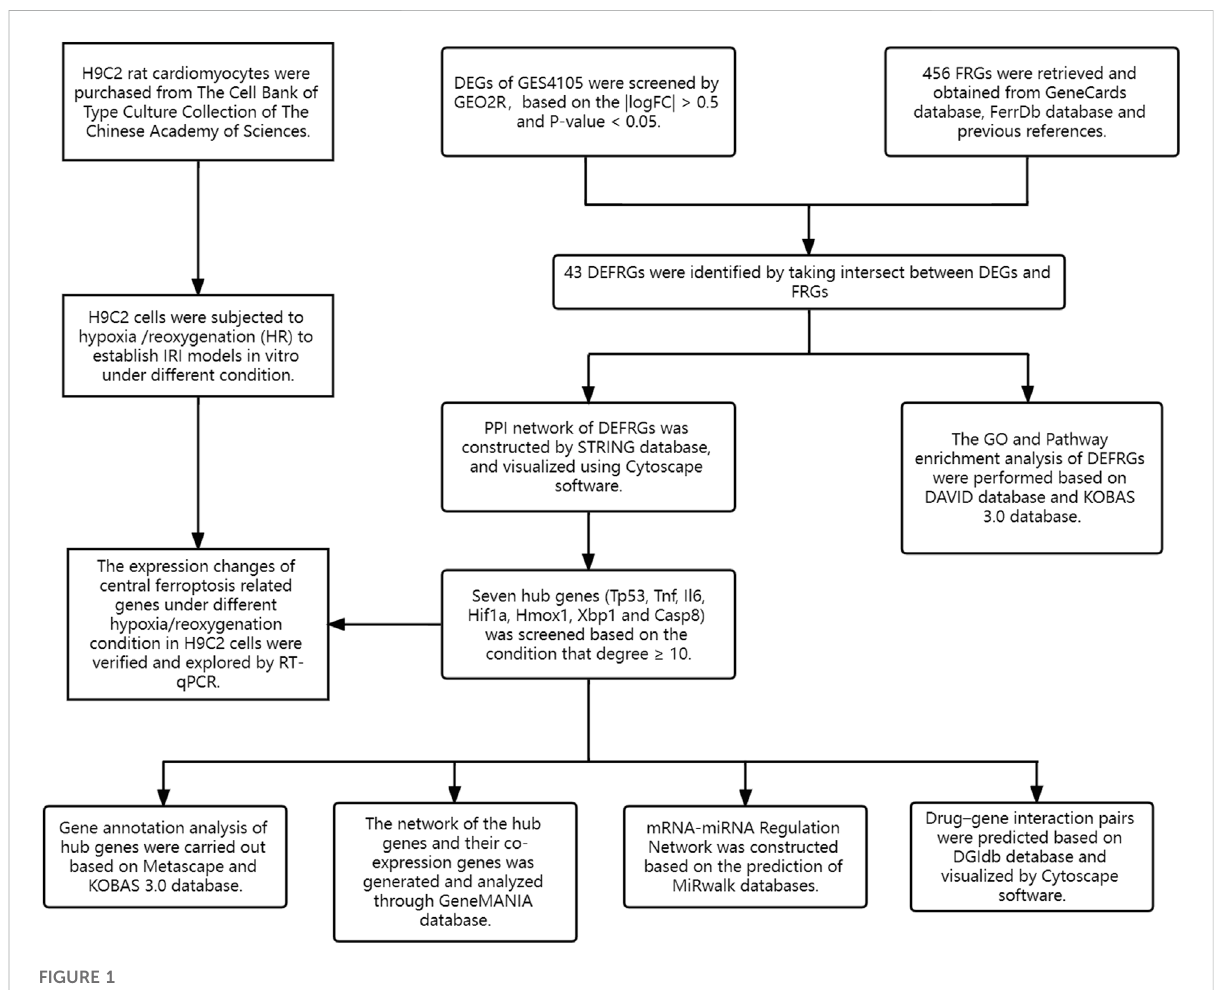
FIGURE 1 Study design fl